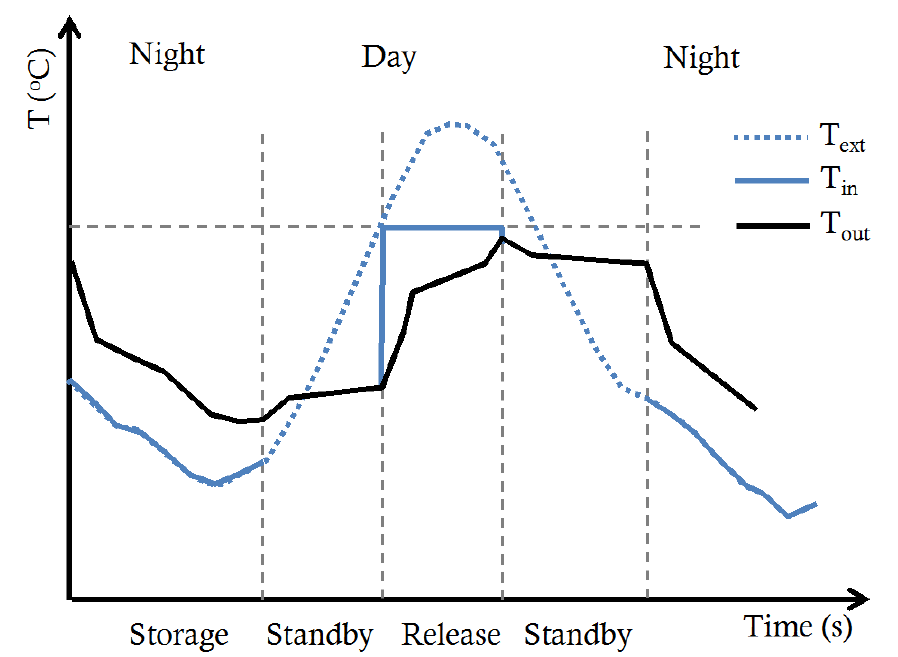
Figure 2. Façade operation: ( a ) Storage; ( b ) Standby; ( c ) Release.